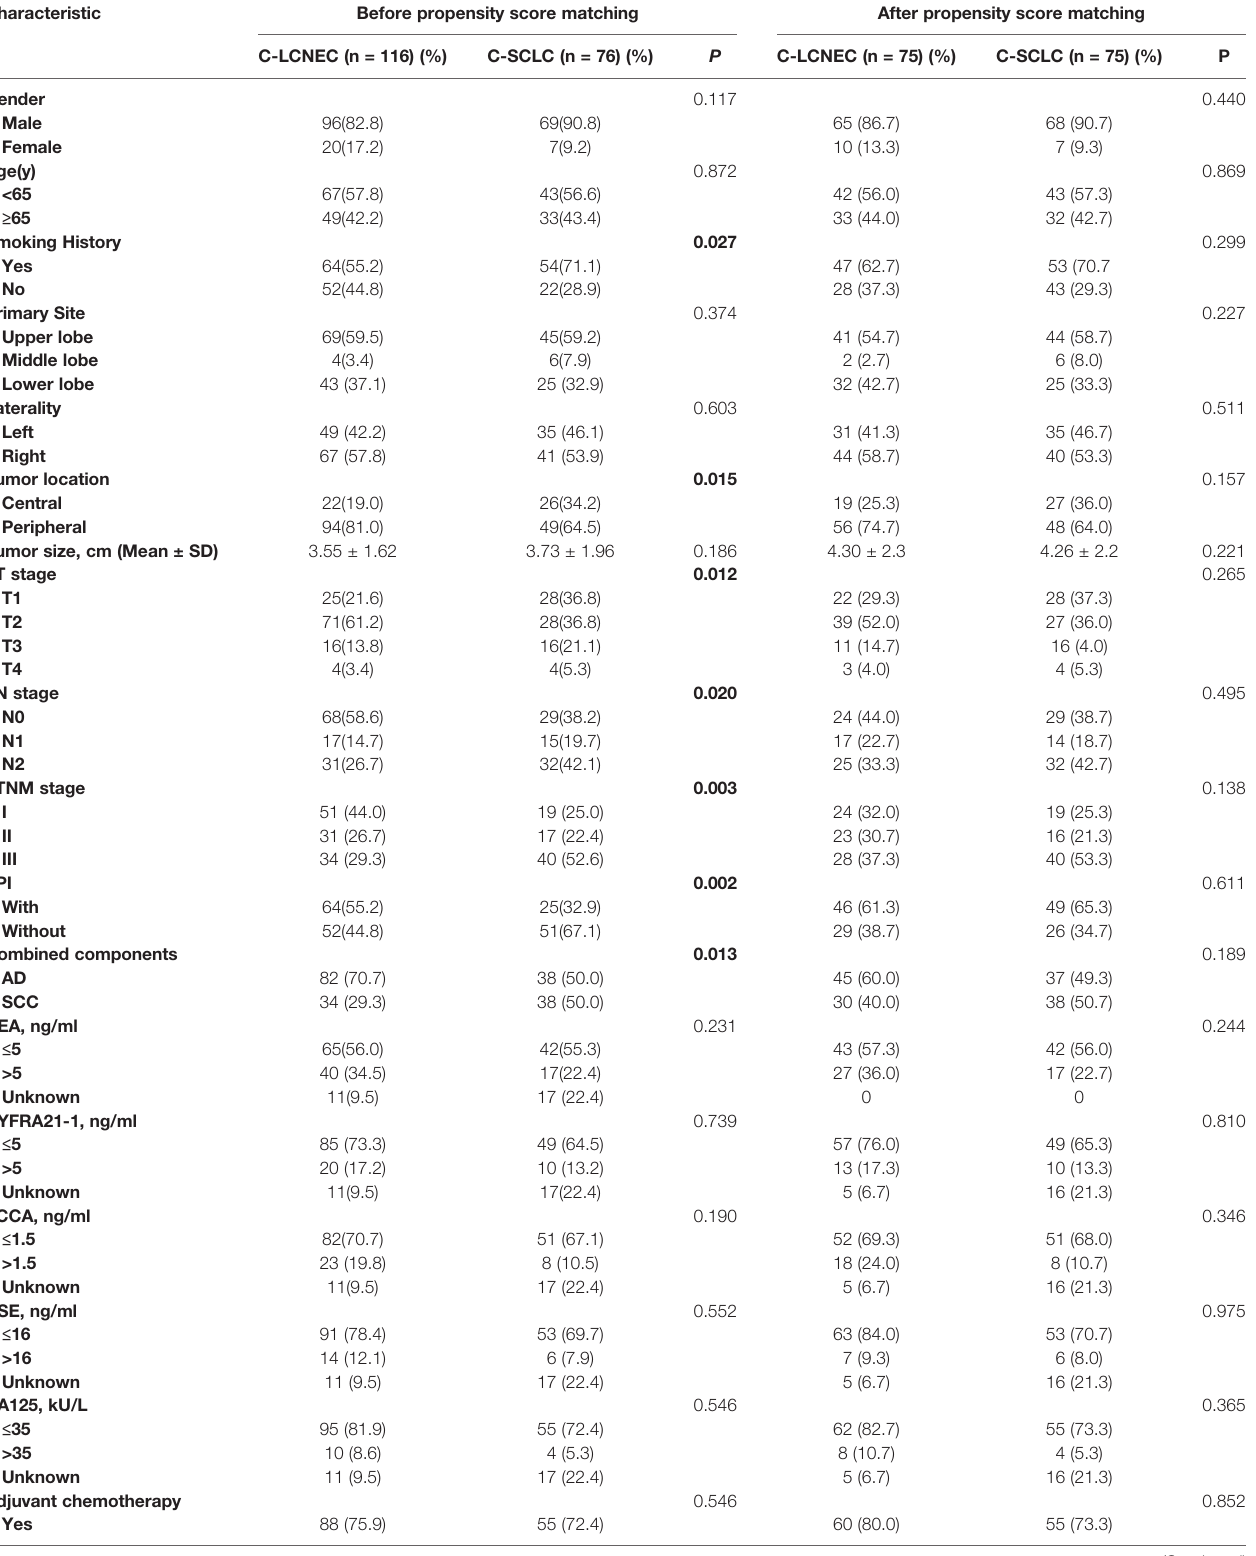
TABLE 1 | Clinical demographics before and after propensity score matching for patients with resected C-LCNEC and C-SCLC. Characteristic